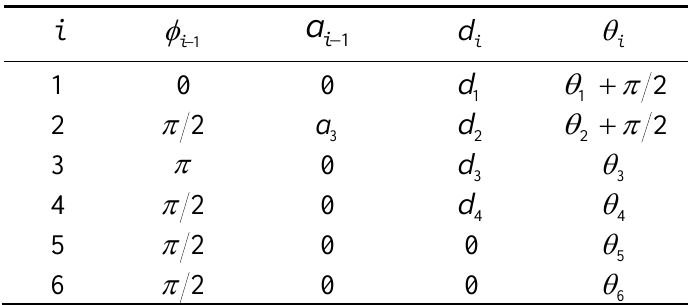
Table 2. Link parameters of each